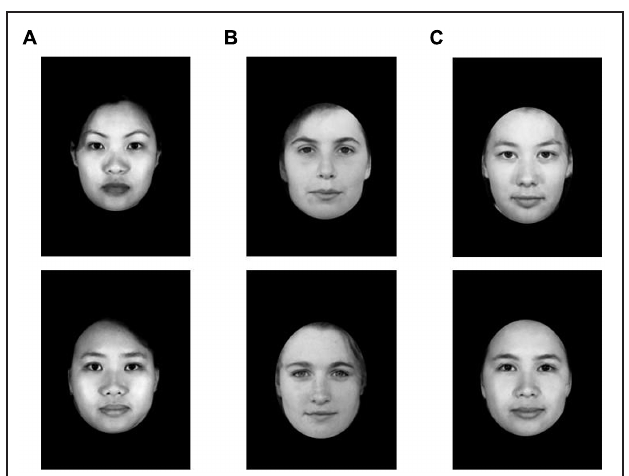
FIGURE 3 | Sample photographs from Study 2. Stimuli used in this study included 24 monoracial faces (12 Chinese morphs and 12 Caucasian morphs), and 24 biracial faces (Chinese-Caucasian morphs). Column (A) : monoracial Chinese; column (B) : monoracial Caucasian; column (C) biracial